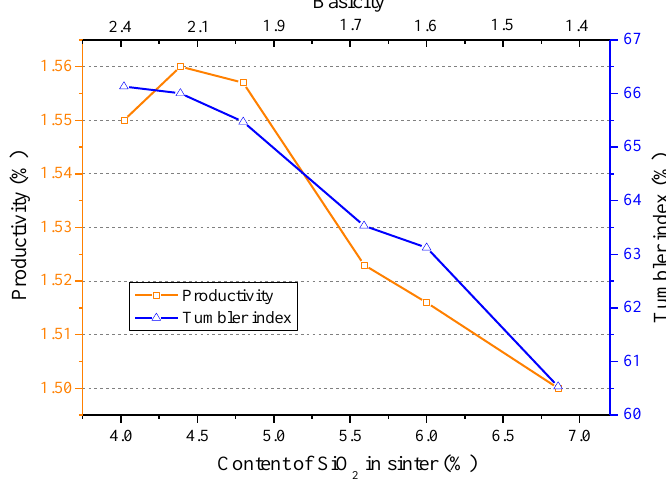
Figure 4. Influence of SiO 2 content on productivity and tumbler index.